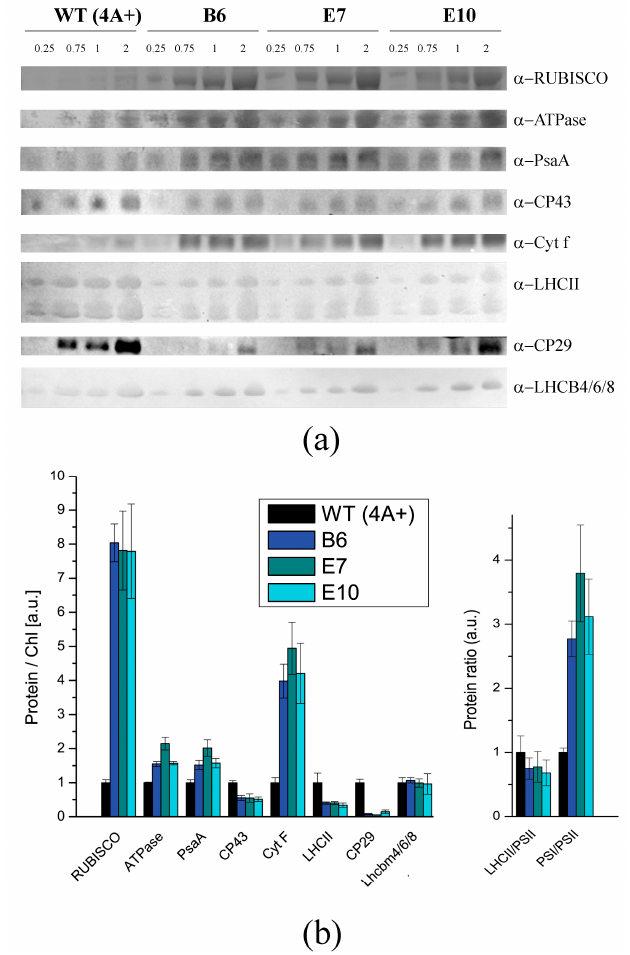
Figure 4. Immunoblot analysis of photosynthetic subunit accumulation. ( a ): immunoblot analysis performed on WT and transformed lines proteins extract using specific antibodies for RUBISCO, ATPase β -subunit, PsaA, CP43, Cyt f, LHCII, CP29 and LHCBM4/6/8 subunits. Micrograms of chlorophylls loaded in each lane are reported on the top. ( b ): Immunoblot signals reported in panel A were analyzed by densitometry to determine the relative protein abundance. Each protein level was normalized to the WT protein level. LHCII/PSII and PSI/PSII ratio are also reported. Standard deviation is indicated as error bars ( n = 4).